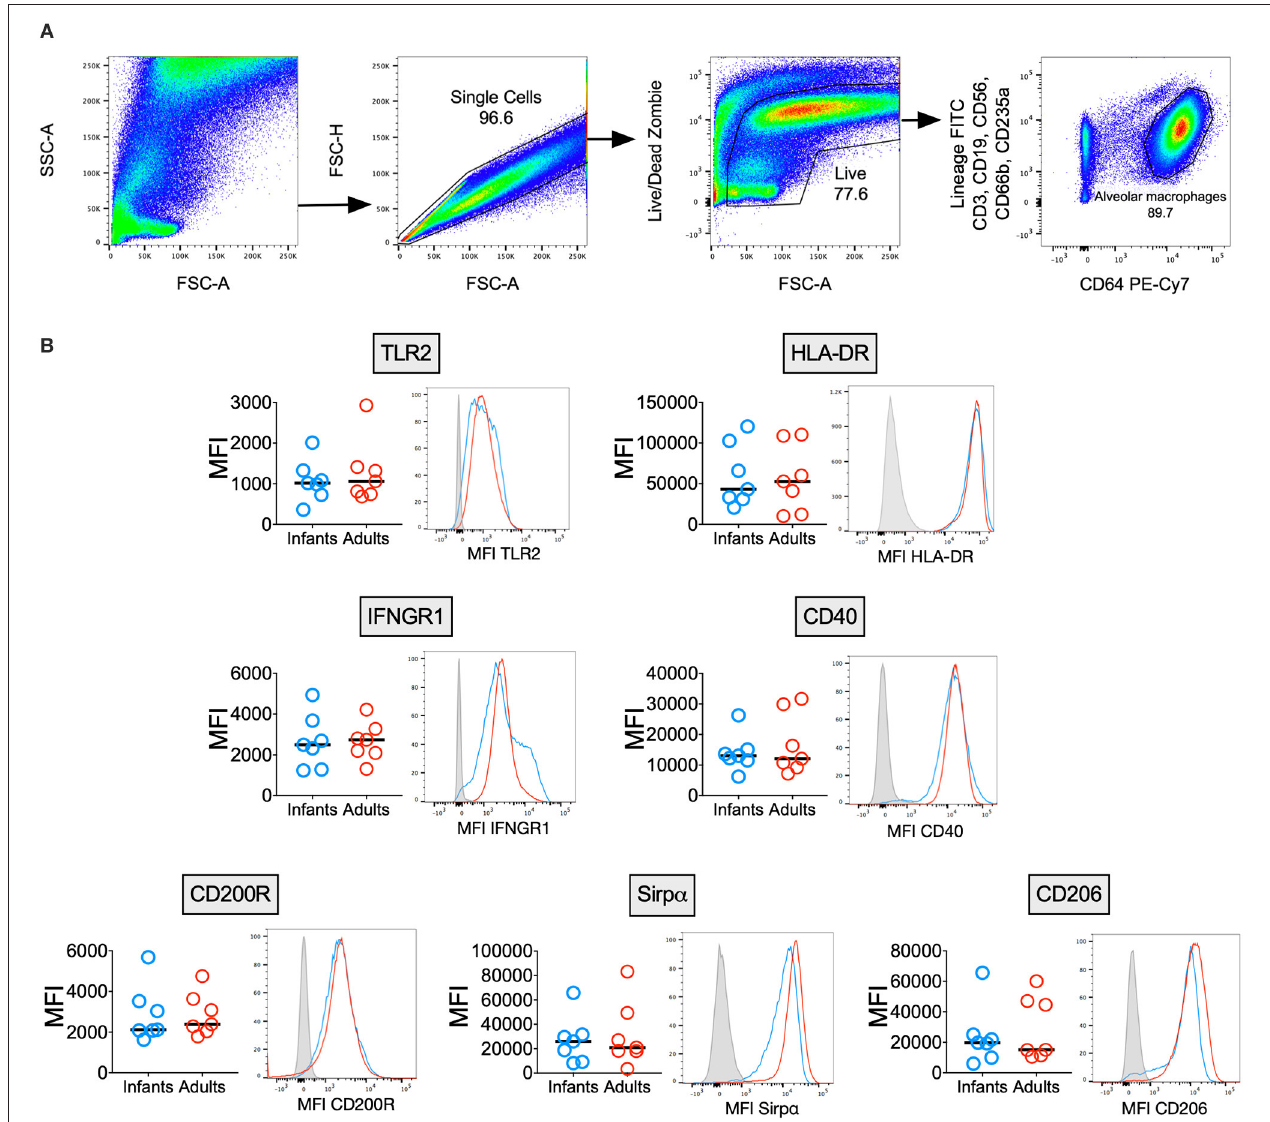
FIGURE 1 | Infant and adult AM φ s have a similar immunophenotype. (A) Representative flow cytometry plots showing gating strategy to differentiate AM φ s based on their high autofluorescence (in the 488 530/30 FITC channel) and high CD64 expression, from lineage positive cells (CD3 + T cells, CD19 + B cells, CD56 + NK cells, CD66b + granulocytes, and CD235a + erythrocytes) and monocytes (low autofluorescence in 488 530/30 FITC channel, lineage negative and CD64 + ). (B) Flow cytometry of AM φ s from seven infant BAL samples (blue representative histogram) compared with seven adults (red representative histogram), with fluorescence minus one (gray representative histogram). Line represents median. MFI, mean fluorescence